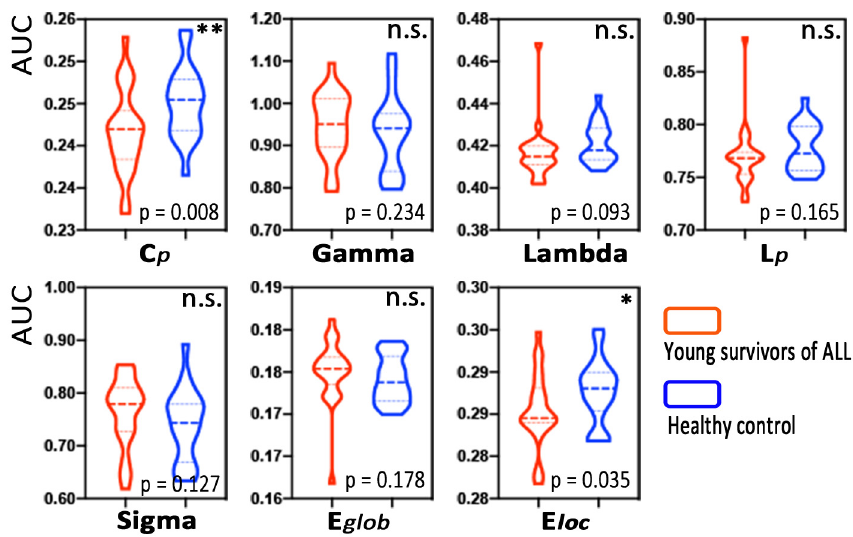
Figure 2. Group differences in global MBN properties between young survivors of acute lymphoblastic leukemia (ALL) and healthy controls. Note: * p < 0.05, ** p < 0.01, n.s., not significant.